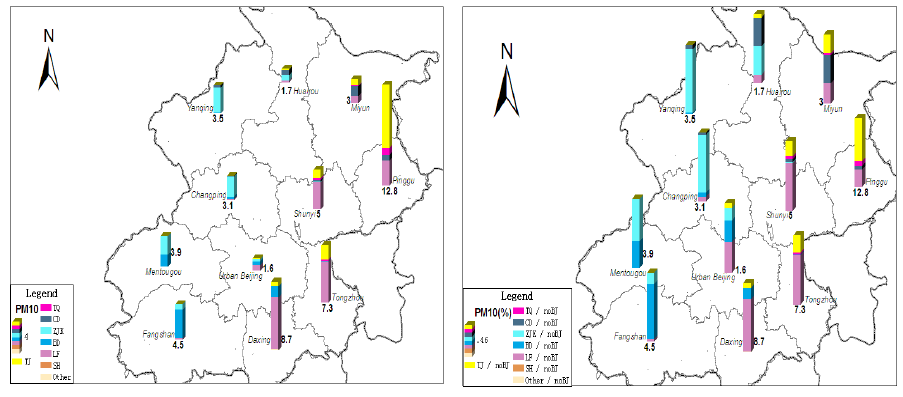
Fig. 10. Surrounding areas contribution to primary PM 10 monthly mean concentration (µgm − 3 ) over Beijing counties without Beijing local contribution (left) with its percentage (right).